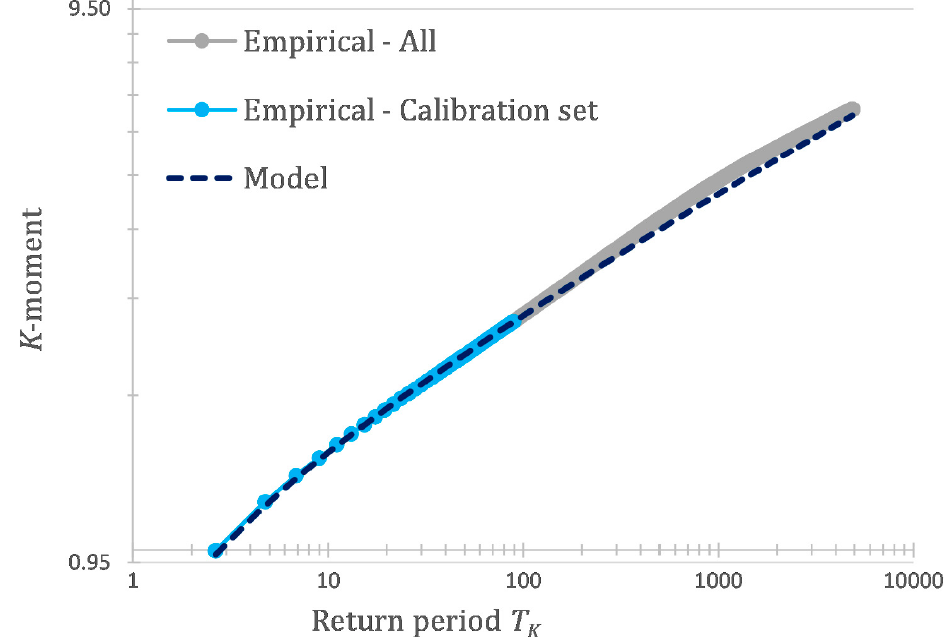
Figure 5. Empirical K-moments of the pooled standardized 24 h rainfall annual maxima sample, their theoretical values by the EV2 distribution and the corresponding return periods.